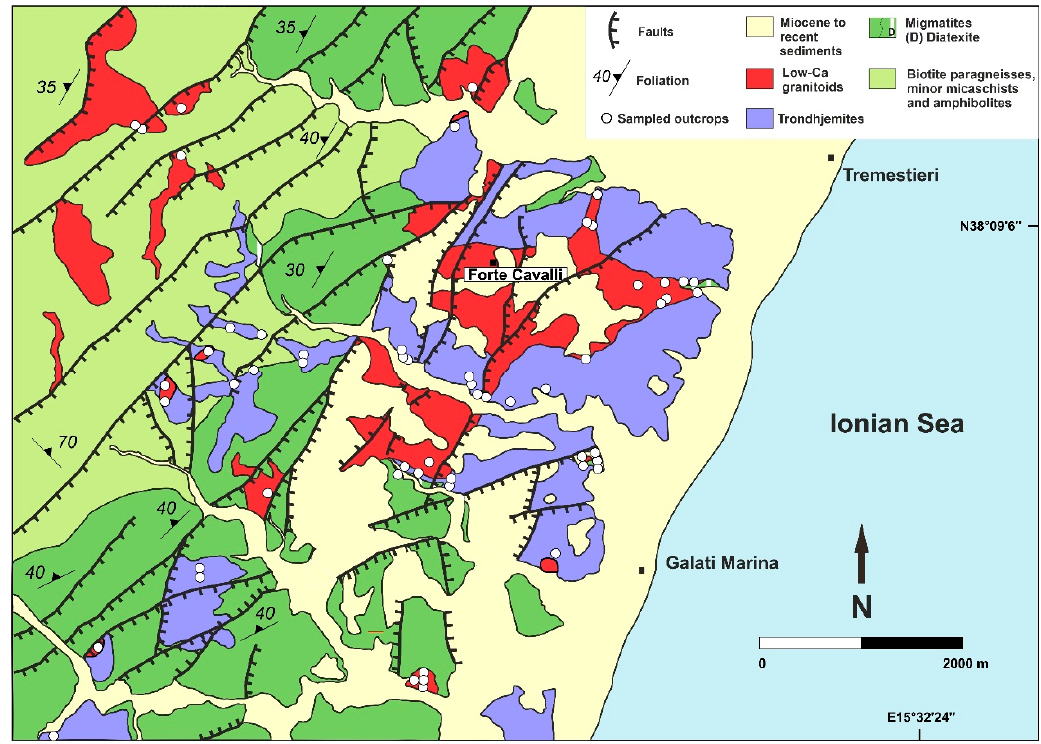
Figure 2. Geological sketch map of the study area, with distribution of the late-Variscan granitoids (modified after [47]; and references therein).